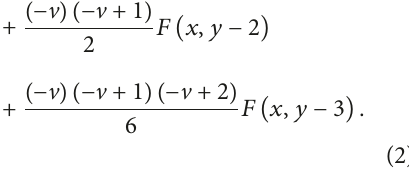
Table 2: 𝐺 𝑦 fractional Gaussian